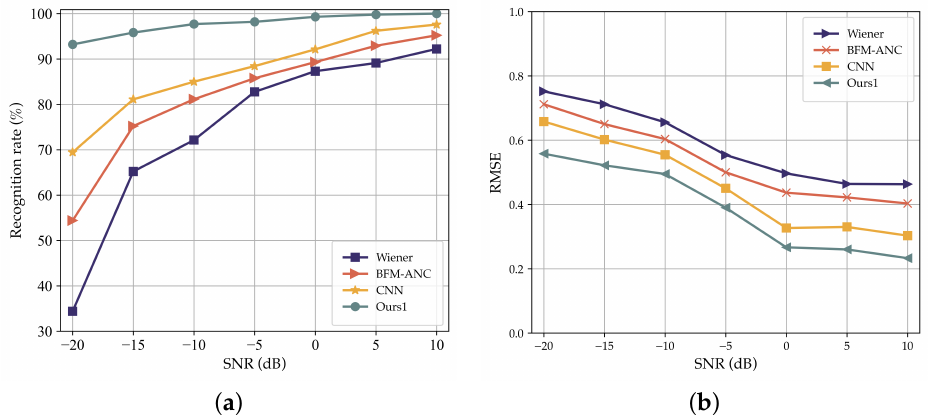
Figure 18. Comparison of signal recognition rate and RMSE of each algorithm: ( a ) the signal recognition rate comparison of each method; ( b ) the RMSE comparison of each